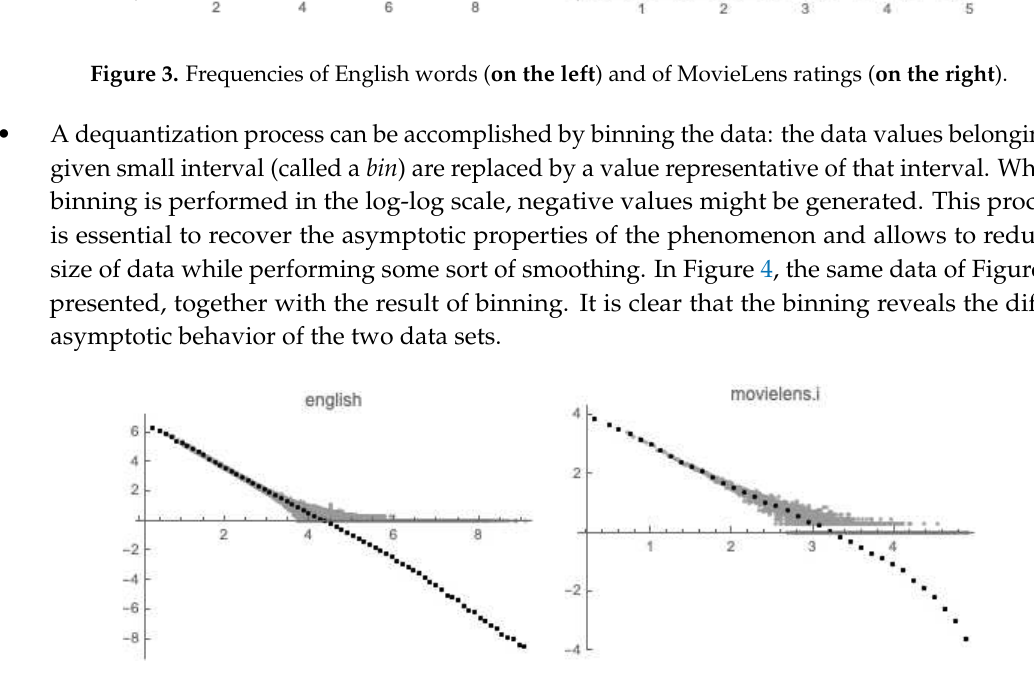
Figure 4. Binned frequencies of English words ( on the left ) and of MovieLens ratings ( on the right